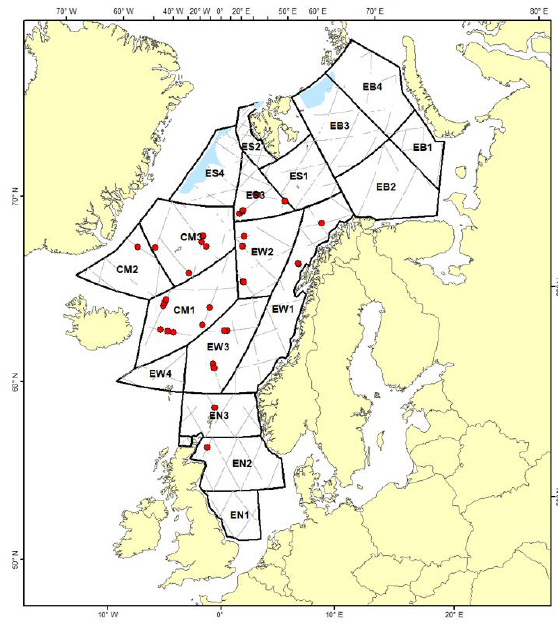
Figure 7. Distribution of sightings recorded as sperm whales during the 2014-2018 sighting surveys. The blue areas represent ice coverage.